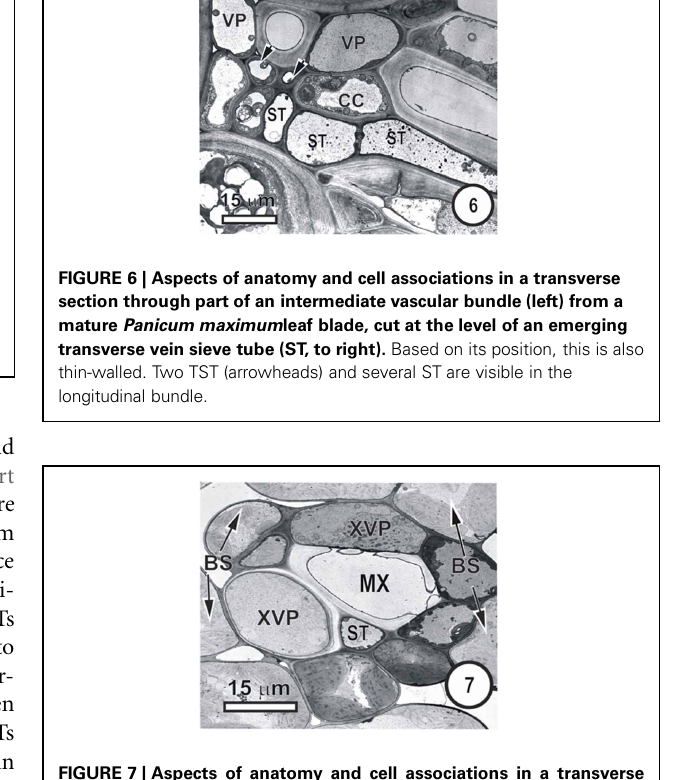
FIGURE 7 | Aspects of anatomy and cell associations in a transverse vein in a Bromus unioloides leaf. A single sieve tube is adjacent to a solitary xylem vessel, which is in contact with (XVP) that are in contact with the single vessel (XV). As is common in many grasses, the bundle sheath is incomplete, and the BS is interspersed with prominent intercellular